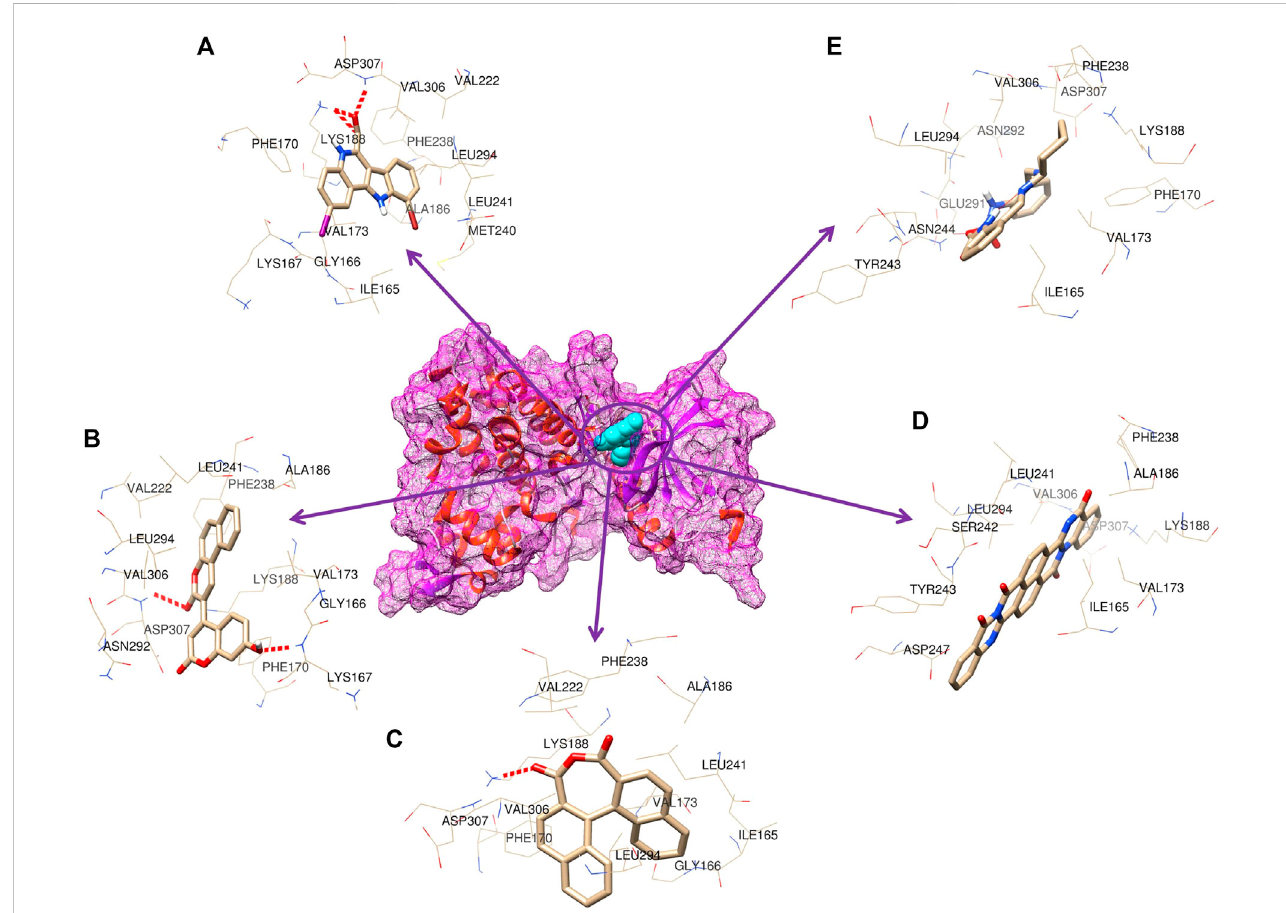
FIGURE 3 3D representation of the molecular interaction between DYRK1A and ligands. (A) 4E3 control, (B) ZINC3843365, (C) ZINC2123081, (D) ZINC5220992, and (E) ZINC68569602.